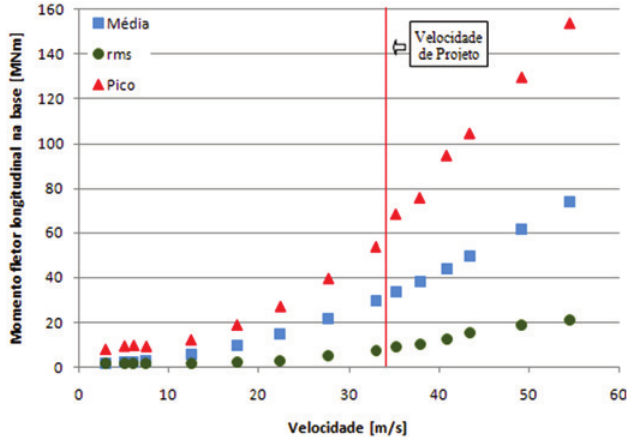
Longitudinal bending moment at the base of the chimney as a function of the wind speed at the top of the structure. Configuration with